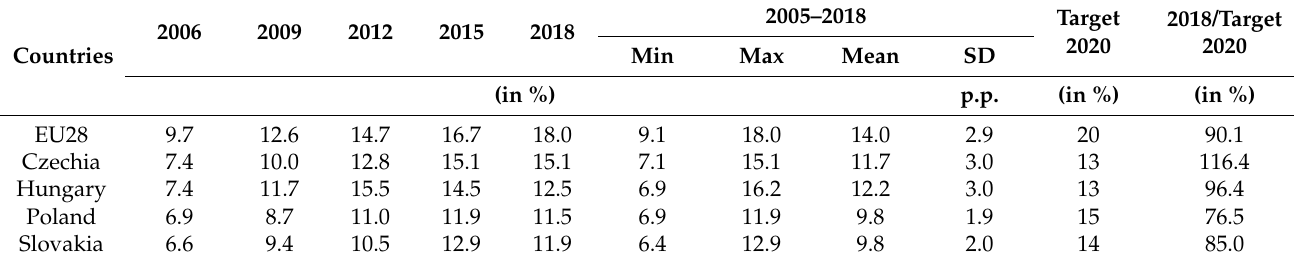
Table 5. Share of renewable energy in gross final energy consumption in V4 countries in the years 2006–2018.